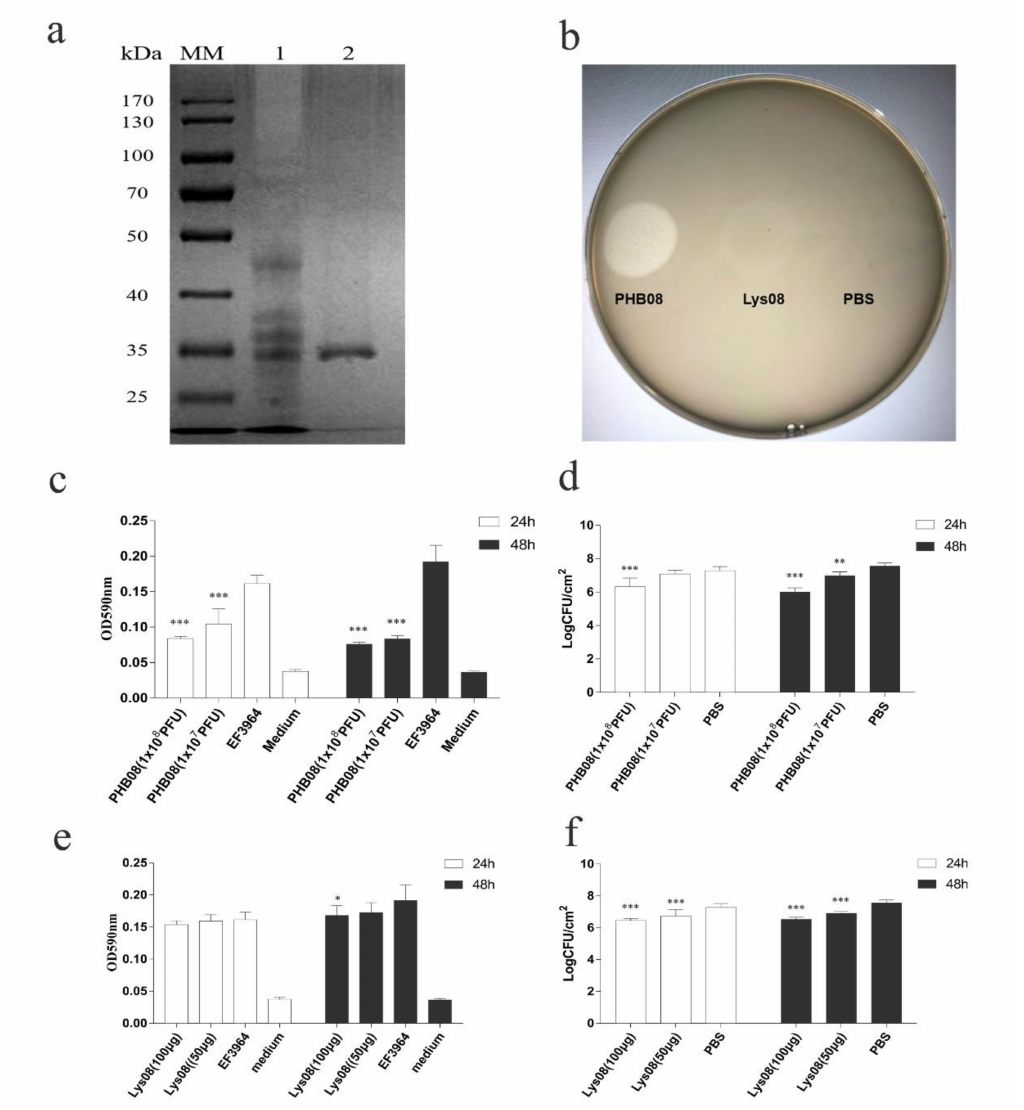
Figure 4. Antibiofilm activity. ( a ) Sodium dodecyl sulfate (SDS) polyacrylamide gel electrophoresis analysis of purified protein lys08. Lane 1: Unpurified protein, lane 2: Purified protein. ( b ) The activity of PHB08 and purified lys08 was determined by spot tests. A total of 5 µ L of endolysin lys08 (5 µ g) was spotted on the plated containing host strain EF3964 at 37 ◦ C for 12 h. ( c ) The value of OD 590 after phage PHB08 with di ff erent titers was applied to biofilm. ( d ) Determination of the number of living cells with phage PHB08 treated. ( e ) Values of OD 590 at di ff erent concentrations of lys08 on biofilm. ( f ) Determination of the number of living cells with enzyme lys08 treated. The bacteria were counted by 10-fold dilutions method. Three independent experiments were performed, and data are expressed as means ± SD ( n = 3). Significance was determined by ANOVA ((* p < 0.05, ** p < 0.01 and *** p <